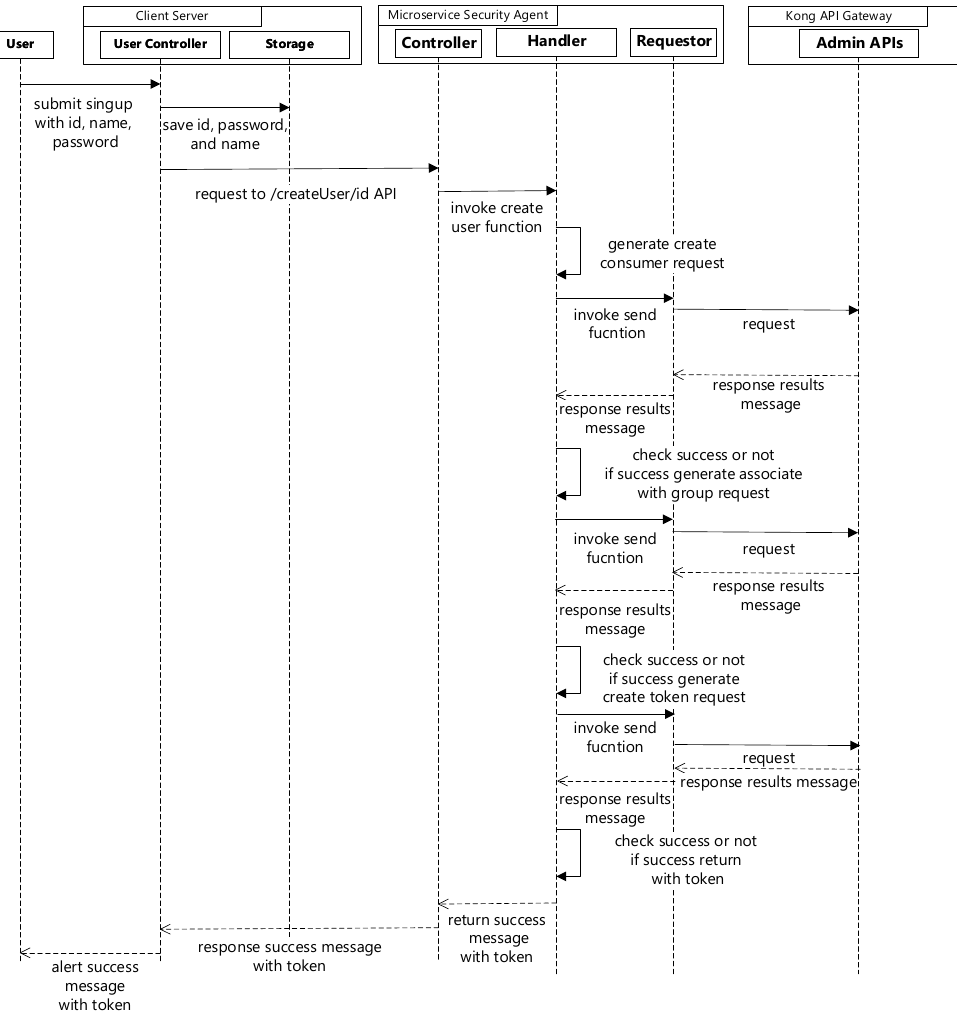
Figure 4. Sequence diagram for user creation.